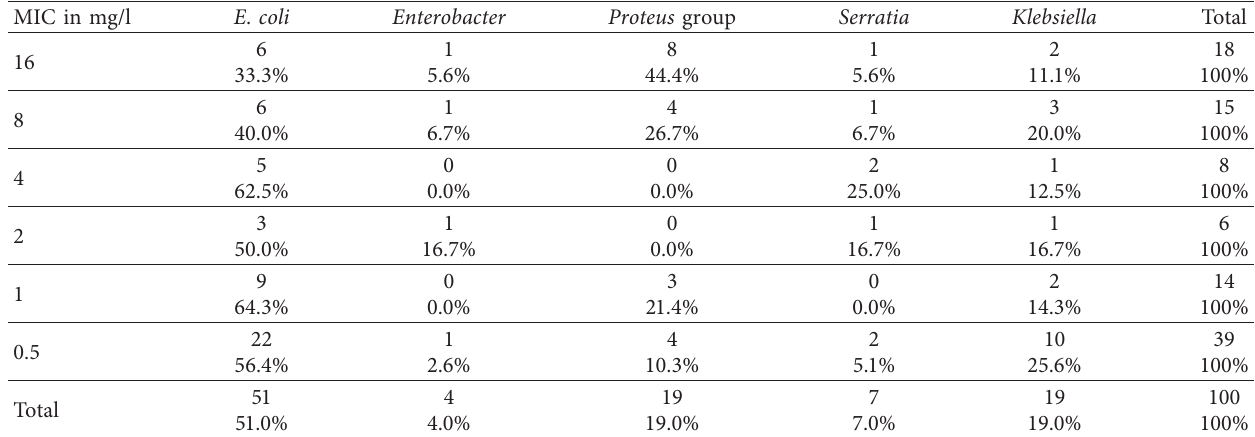
Table 4: MIC values for various Enterobacteriaceae